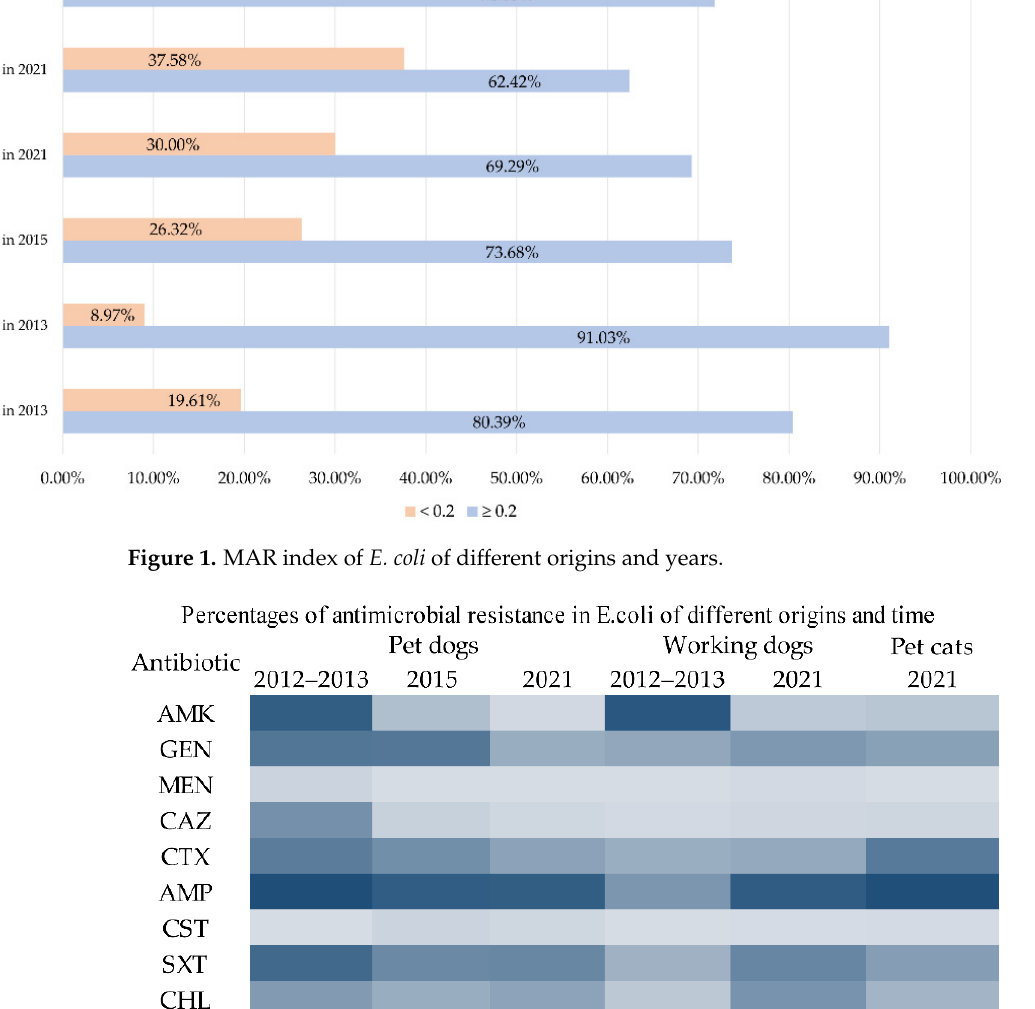
Figure 1. MAR index of E. coli of different origins and years.